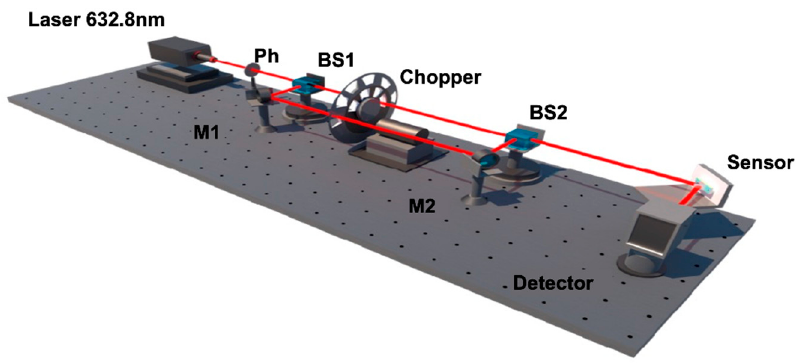
Figure 4. Experimental setup for measuring the differential lateral position shift (L shift ).